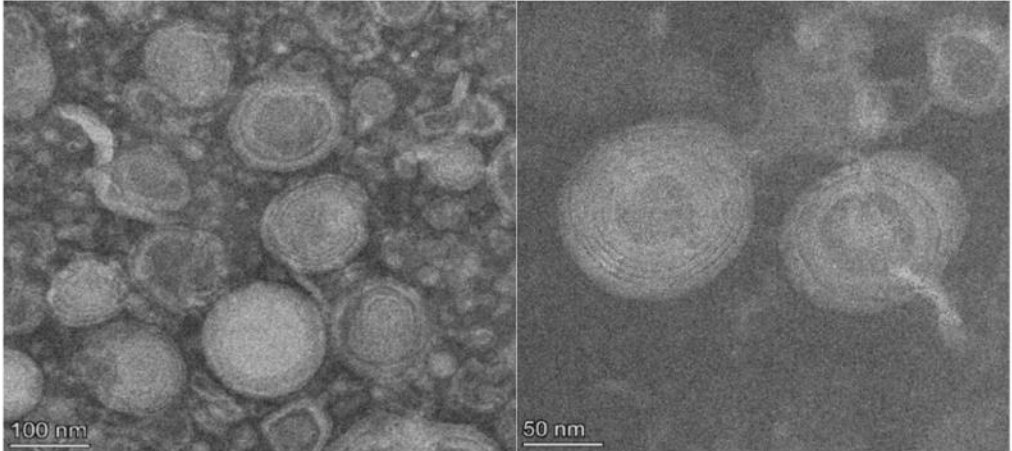
Figure 1. TEM records of the structure of ELICE16INDURES liposomes. TEM recordings showed a multilamellar liposome structure in the range of 100 – 200 nm. multilamellar liposome structure in the range of 100–200